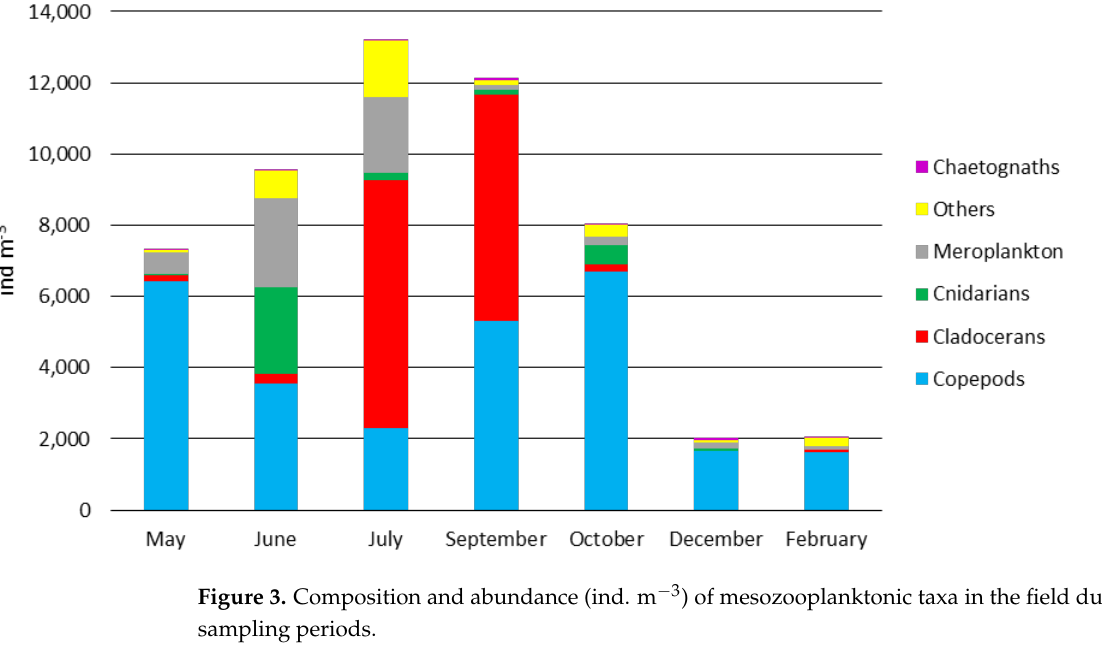
Figure 2. Temperature ( a ) and salinity ( b ) profiles measured close to positions where sardine diet and mesozooplankton were described.